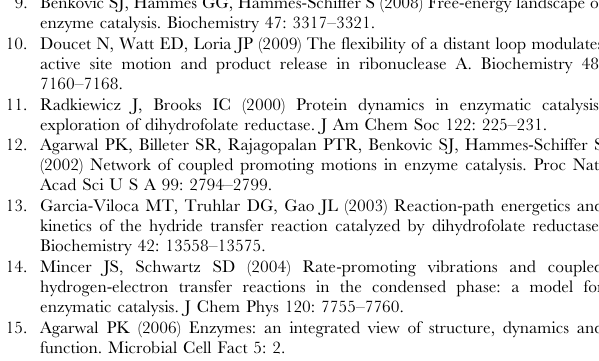
Figure S9 Cross-correlations in RNaseA: Regions H1–H3 and S1–S4 correspond to correlations observed from secondary structural elements ( a 1– a 3, b 1– b 5), respectively. Regions I1–I2 correspond to distal correlations observed. The distal correlations observed from RNaseA are depicted in Table S5. Figure S10 Details of conserved networks in RNaseA. The flexible loops on the surface are connected to the active-site through conserved residues and disulphide bonds as listed in Table S6. Figure S11 The dynamic cluster methodology for identification of protein regions exhibiting similar motions over the course of MD simulation(s). Figure S12 Validation of the enzyme flexibility. Comparison of the computationally obtained flexibility of the enzyme models (root mean square fluctuations) is compared with the temperature factors ( b -factors) from the X-ray structures. The results show reproducible trends in high and low areas of enzyme flexibility. (TIF) Movie S1 Mode showing the highest coupling to cis/trans isomerization reaction. For more information, see Text S1. (MPG) Movie S2 Mode showing the second highest coupling to cis/trans isomerization reaction. For more information, see Text S1. (MPG) Movie S3 Mode showing the third highest coupling to cis/trans isomerization reaction. For more information, see Text S1. (MPG) Movie S4 Mode showing the highest coupling hydride transfer reaction. For more information, see Text S1. (MPG) Movie S5 Mode showing the second highest coupling hydride transfer reaction. For more information, see Text S1. (MPG) Movie S6 Mode showing the third highest coupling hydride transfer reaction. For more information, see Text S1. (MPG)